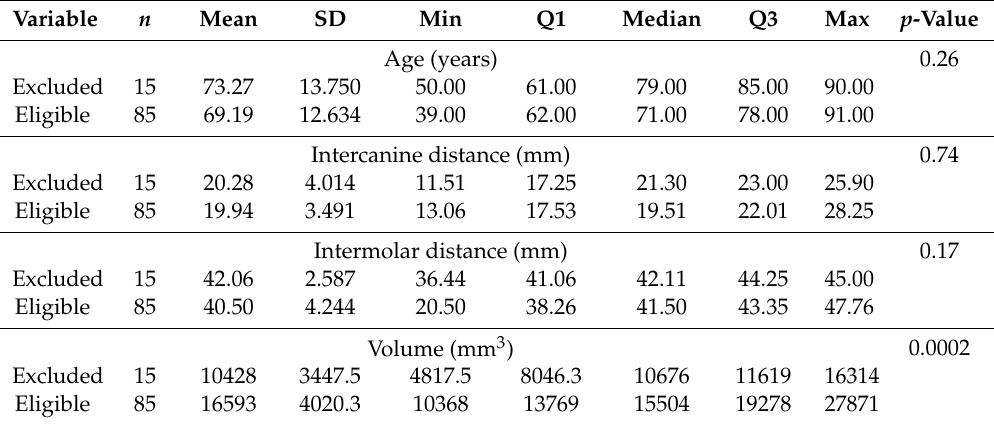
Table 2. Influence of age, mandibular arch, and volume on patient